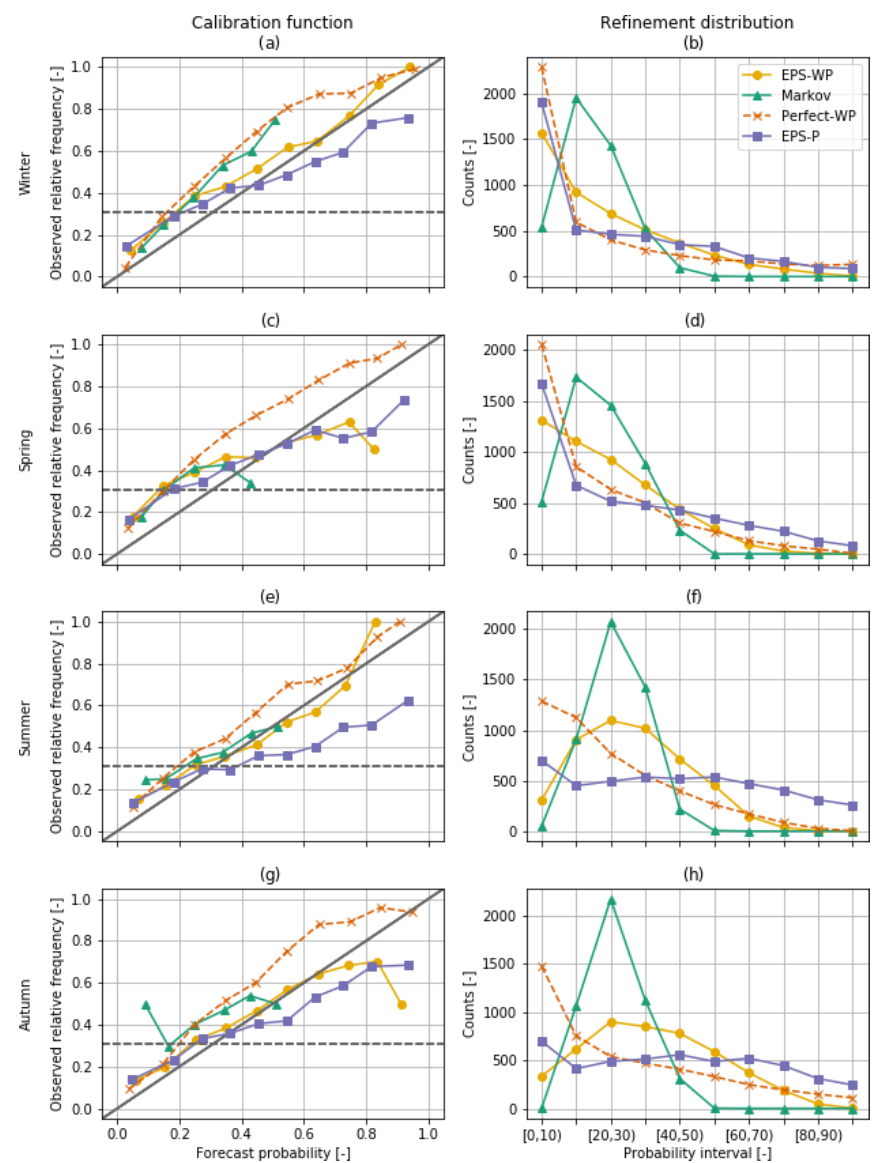
Figure 10. Calibration functions (first column) and refinement distributions (second column) for mild drought with a 31d lead time. For the calibration function diagrams, the solid diagonal line indicates perfect reliability and the dashed horizontal line is the event relative frequency for mild drought